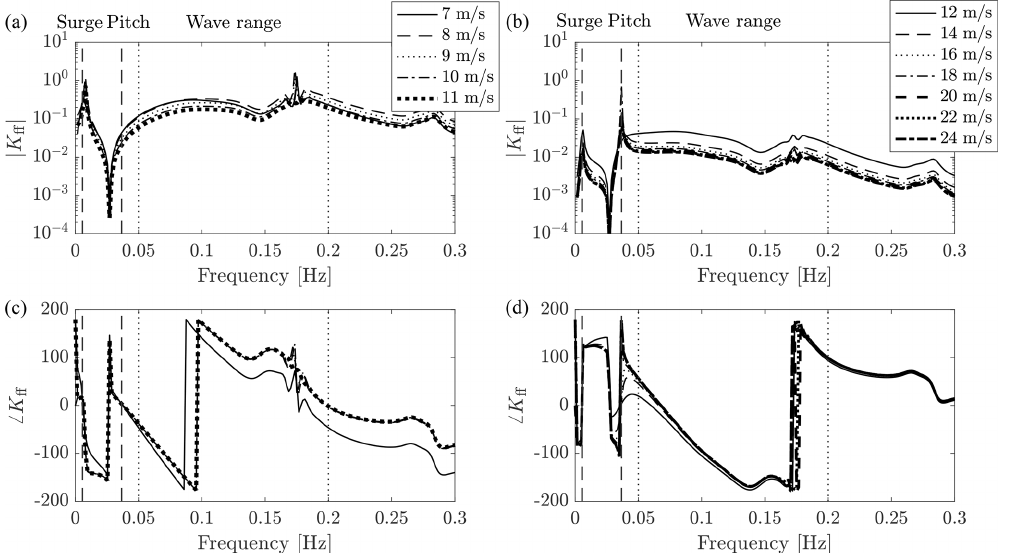
Figure 4. The feedforward controller transfer function K ff for below-rated (a, c) and above-rated (b, d) operating conditions. The vertical dashed lines are the frequency of the platform surge and pitch modes; the frequency range where waves are active is enclosed by the vertical dotted